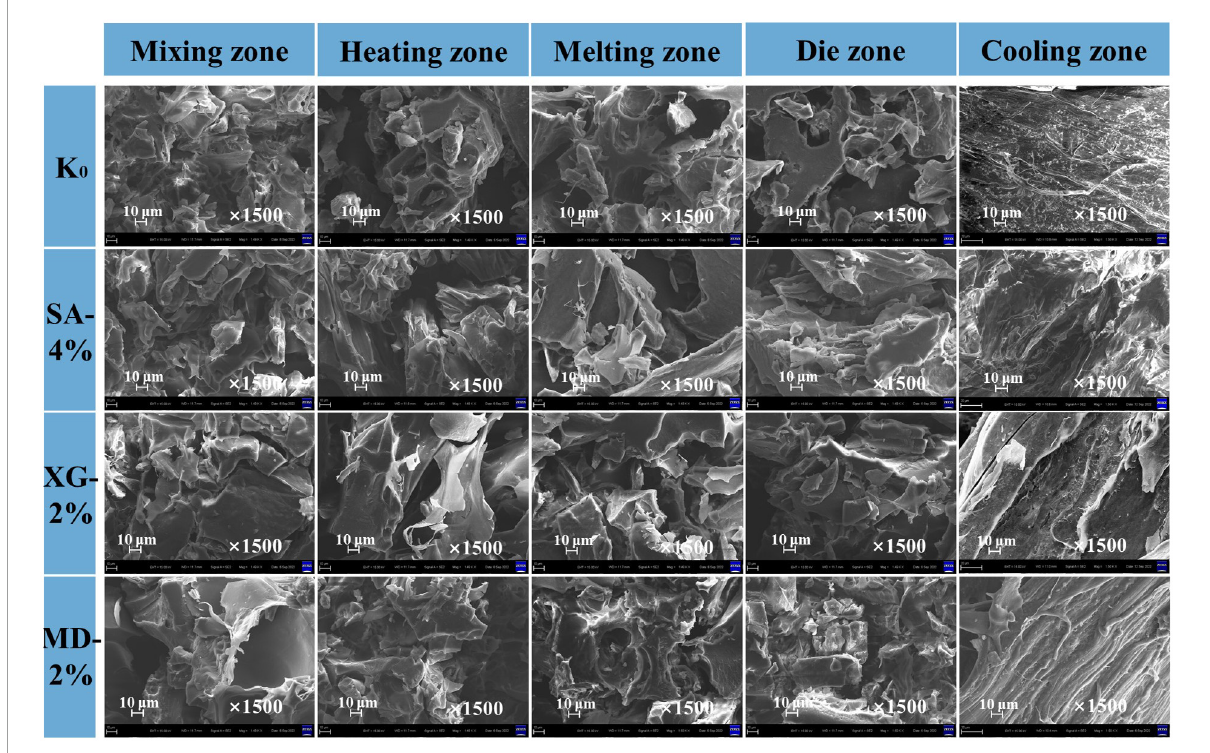
FIGURE8 Scanning electron microscopy (SEM) images of the extrudates from different